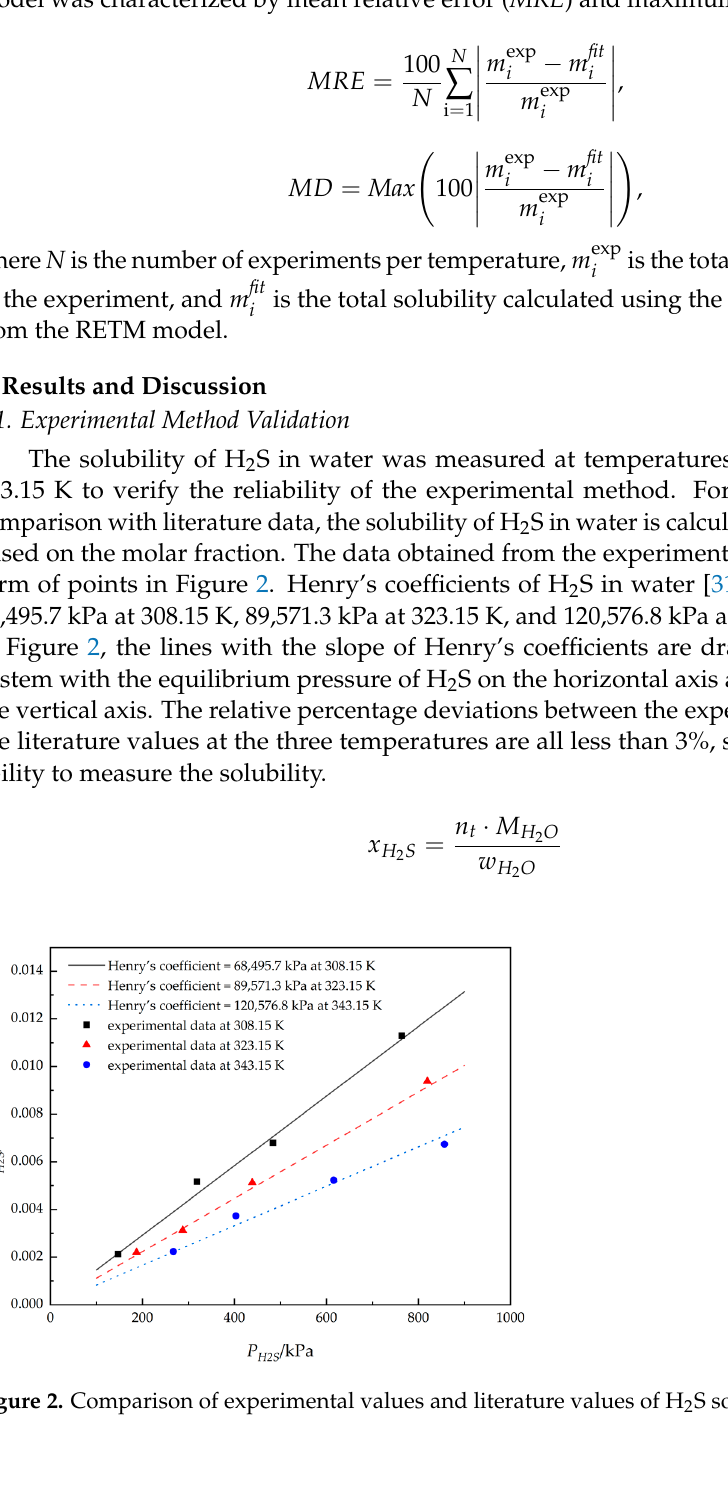
Figure 3. For detailed solubility data with uncertainty, see Table S2 in the Supporting Ma- terials section. As can be seen, the total solubility of H 2 S increases with increasing pressure and decreasing temperature at the same r , which is similar to the solubility of most gases. It not only shows that our experimental device is reliable, but also indicates that the phase equilibrium of iron-based ionic liquid and H 2 S follows the same law as other traditional solvents.